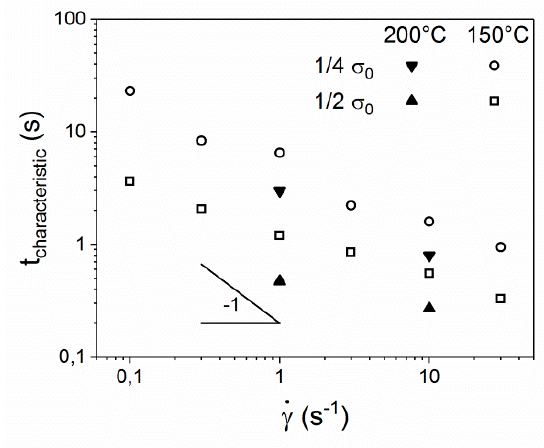
Figure 10. Characteristic timescale of the shear stress relaxation as a function of shear rate.